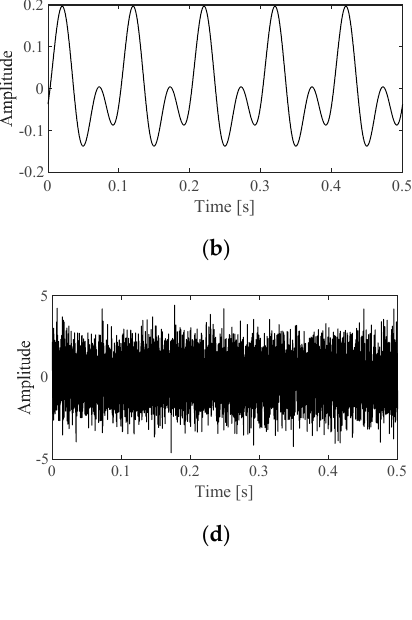
Figure 1. Illustration of designing SEs of MF. A simulated signal s ( t ) is used to verify the de-noising ability of AMF in the section. The mathematical expressions of the simulated signal s ( t ) and its four components are provided in Equation (15) and their corresponding time domain waveforms are presented in Figure 2a–e, respectively. In Equation (15), p ( t ) is the impulse signal and its demodulated amplitude is represented by A ( t ) . s ( t ) simulates a rolling bearing with a failed inner race and the fault characteristic frequency (FCF) of the inner ring is set as 97 Hz. Theoretically, there exists a random slip between the rolling elements and the raceways and the random slip is represented by τ i . In Figure 2e, the impulse features are hidden completely by the strong interferences and the direct ES result of s ( t ) is shown in Figure 2f, on which only the FCF of the inner race could be identified clearly. The AMF is applied on the original signal as shown in Figure 2e and the filtered signal is presented in Figure 2g. Compare Figure 2g with Figure 2e and the impulse features are enhanced evidently. The kurtosis index of the signal shown in Figure 2g increases about 300% compared with the original signal through calculation. The ES analysis result of the de-noised signal is shown in Figure 2h, based on which not only the FCF on the inner ring could be extracted but also its harmonics are also extracted perfectly.